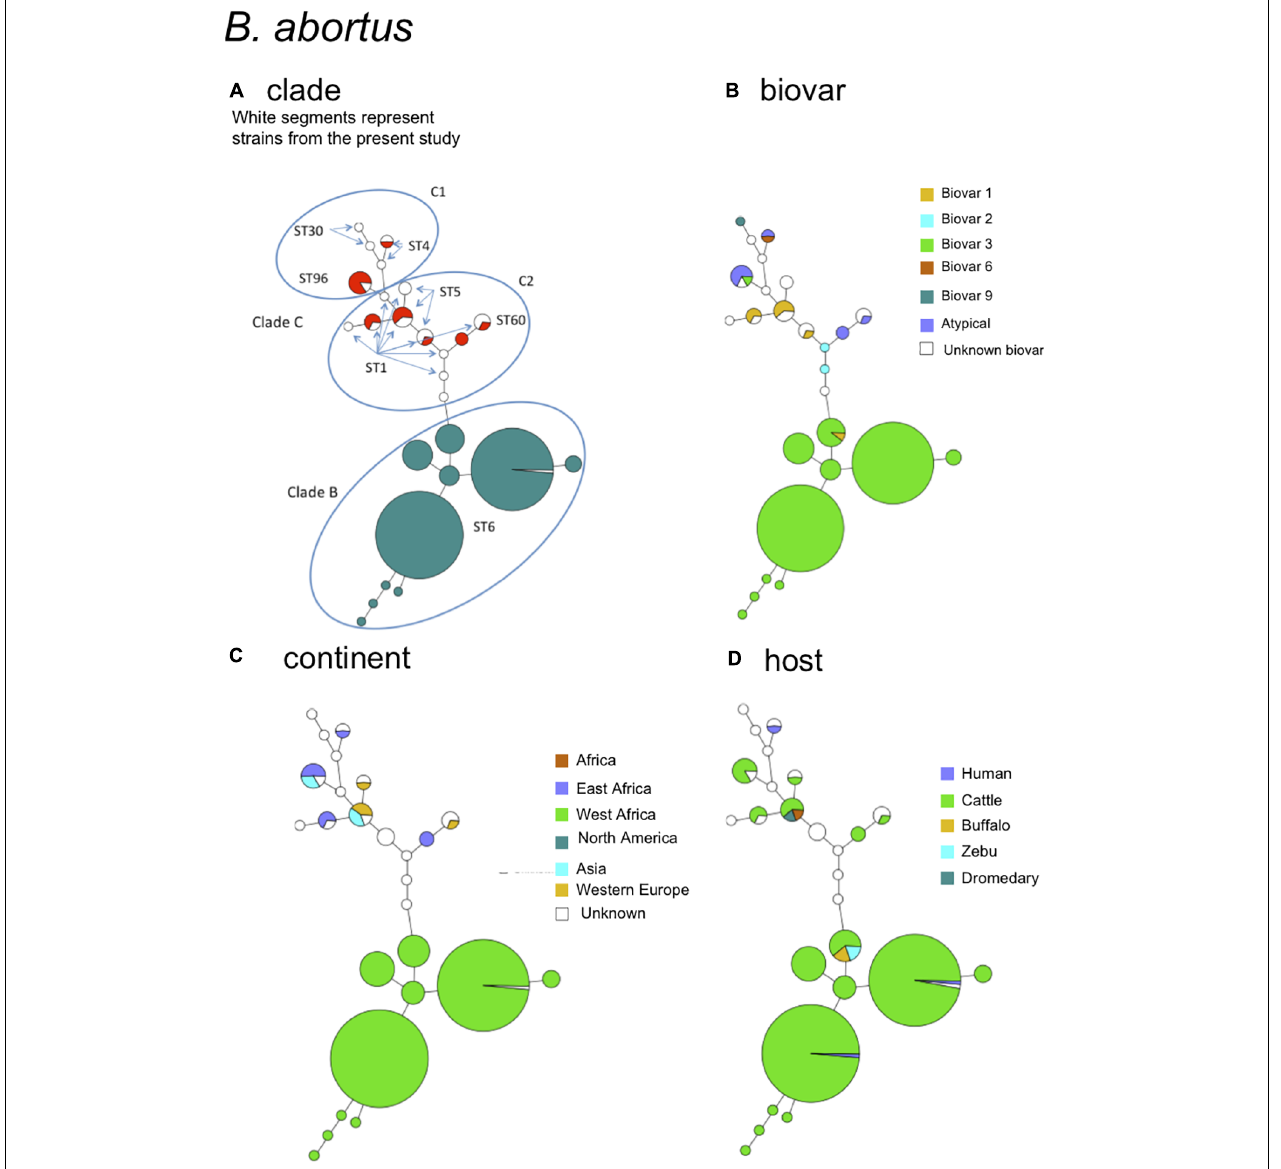
FIGURE 3 | B. abortus intraspecies diversity view provided by MLVA11. 232 entries are used including 213 B. abortus strains from this study and 19 representative entries from in silico data. The same MLVA11 minimum spanning tree was color-coded according to different characteristics. (A) Color coding according to assignment to B. abortus clade C or B. abortus clade B. Uncolored (white) entries correspond to in silico data. The MLST21 ST genotype for the white entries is indicated and was used to deduce the A, B, or C clade assignment defined by Whatmore et al. (2016). A tentative assignment of clades C1 and C2 is also proposed. (B) Color coding according to biovar (white when unknown). (C) Color-coding according to geographic origin defined at continent level (white when unknown). (D) Color-coding according to host (white when